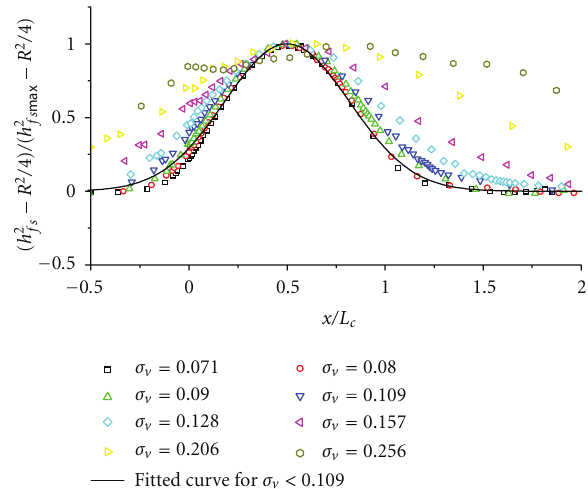
Figure 5: Universal profiles of the free surface at di ff erent σ v , h/H = 0 . 50.